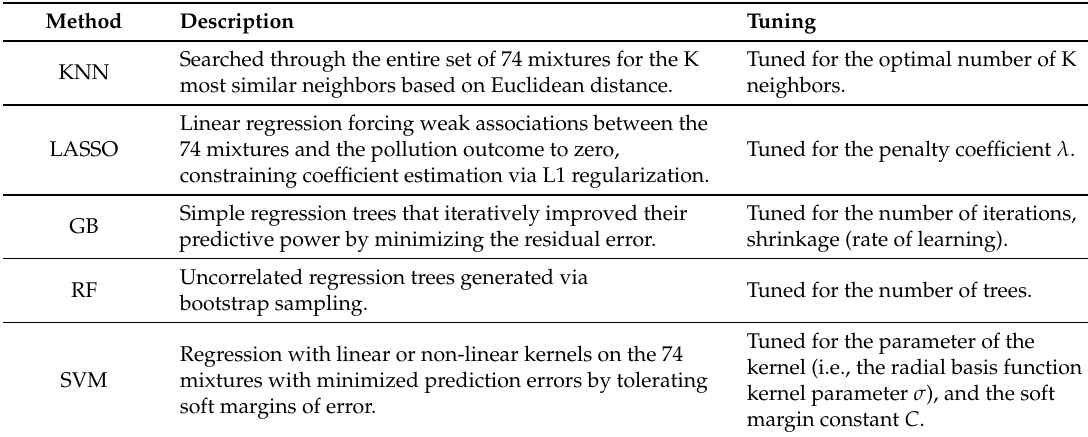
Table 1. Description of machine learning methods applied to the 74 MISR mixture AOD retrievals to predict PM 2.5 , PM 10 , and SO 2